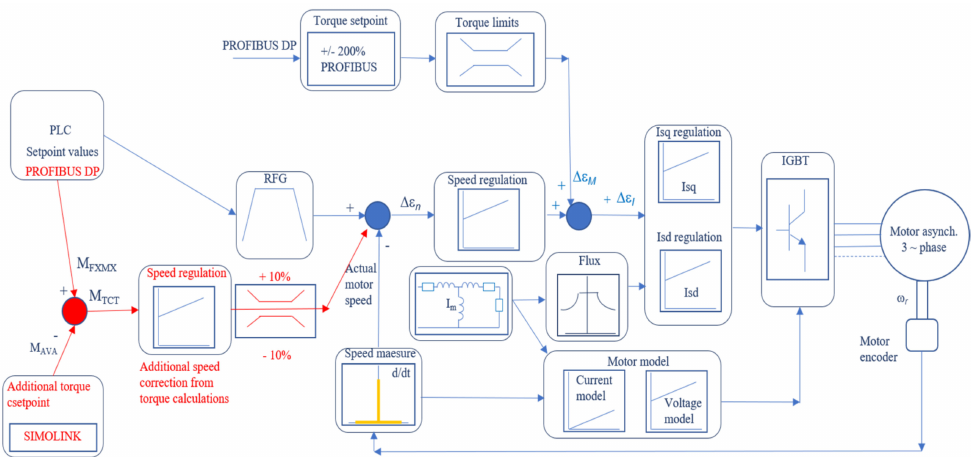
Figure 7. Block diagram of the FOC control algorithm with torque correction for an induction motor in the speed